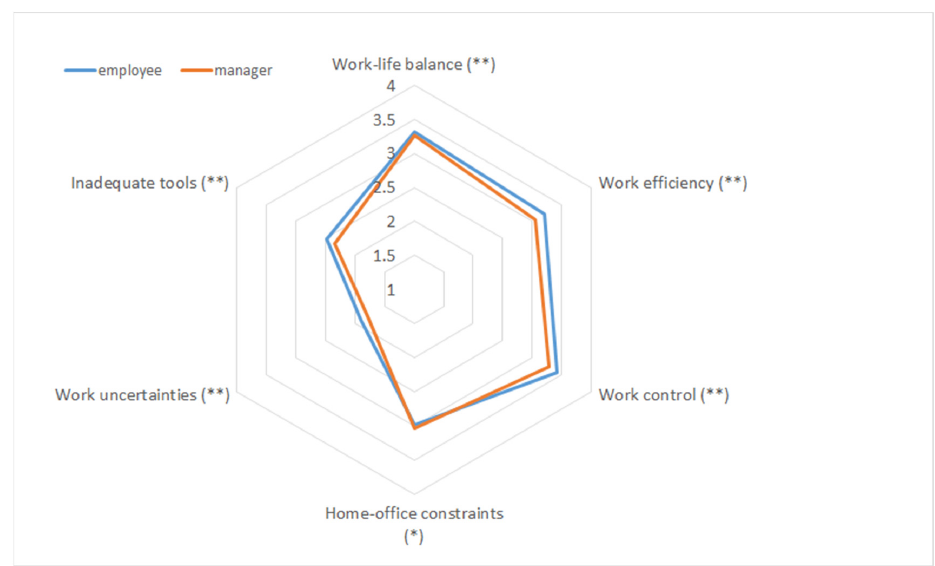
Figure 2. Visualising the differences in the factors between the employees and managers (* p < 0.05, ** p < 0.01)